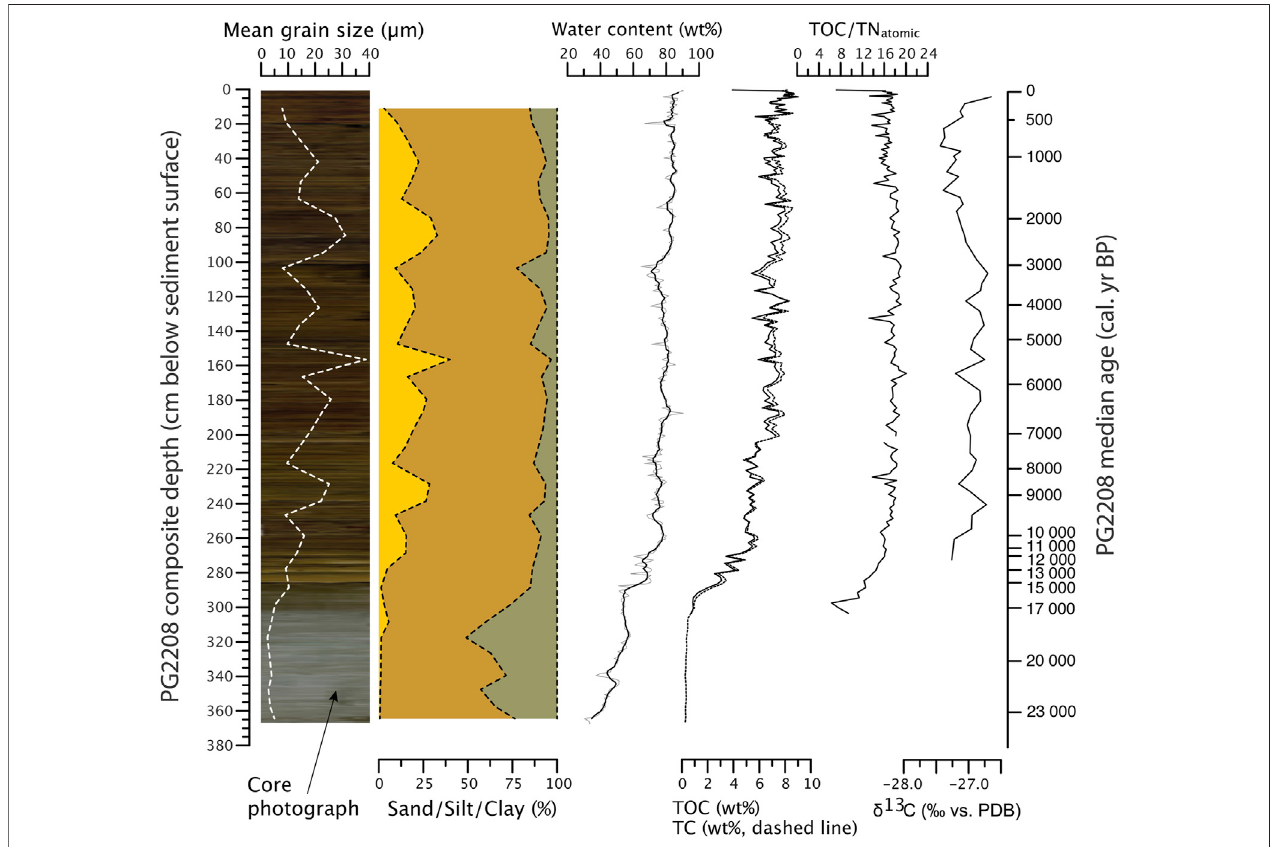
FIGURE 3 | Variability of grain size and organic geochemistry (TOC, total organic carbon; TC, total carbon; TN, total nitrogen; z 13C, stable carbon isotopes) in Bolshoe Toko (sediment core PG2208). A stretched core photograph is added below the mean grain-size data at the left side of the fi gure showing the lithological development and fi ne